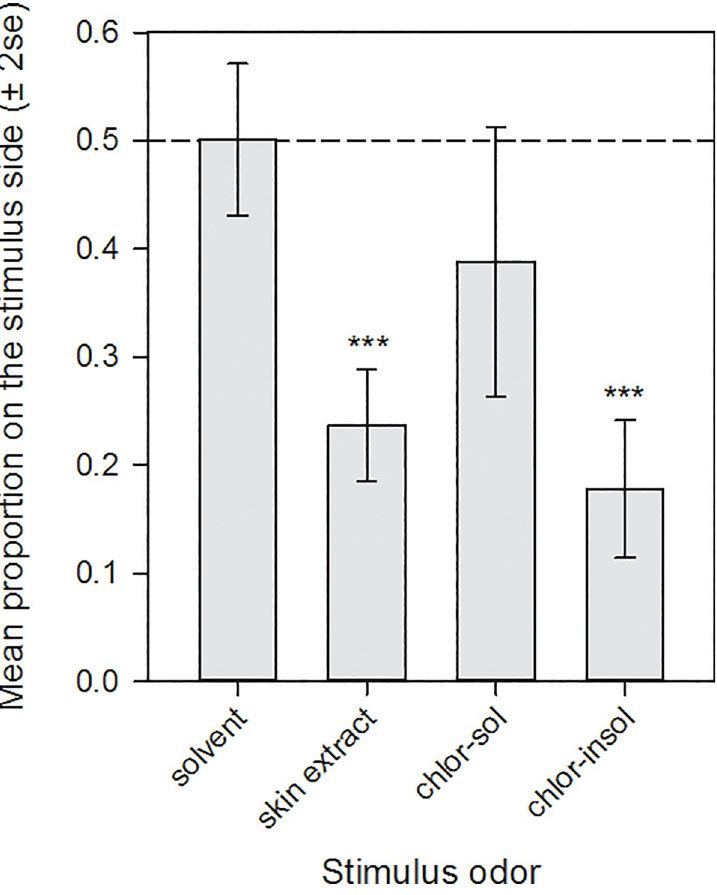
Fig 4. The mean proportion ( ± 2 se) of migratory-phase sea lampreys on the side of a laboratory raceway receiving one of four stimulus odors: (a) a solvent control, (b) the full aqueous ethanolic extract from sea lamprey skin, (c) the chloroform-soluble fraction of the aqueous ethanolic skin extract, and (d) the chloroform-insoluble (water-soluble) fraction of the aqueous ethanolic skin extract ( ��� indicates P < 0.0001 in t-tests of the mean reaction vs. the solvent